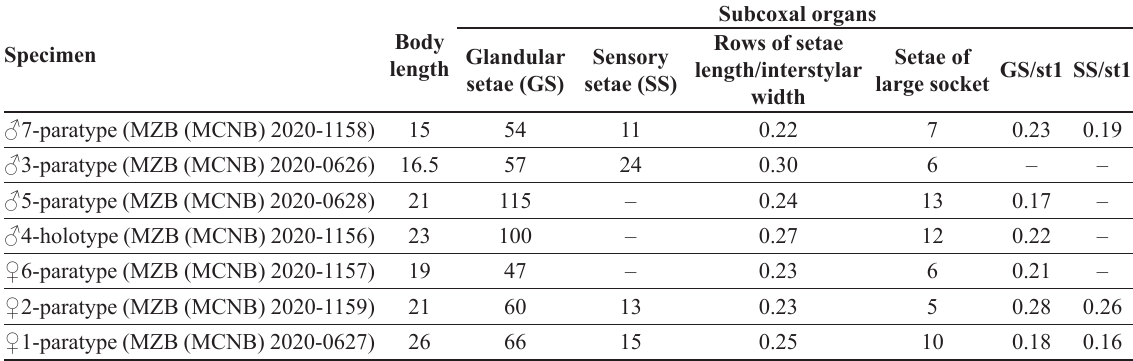
Table 6. Mueggenjapyx brehieri Sendra & Komerički gen. et sp. nov., subcoxal organs with number of glandular, sensory setae and large socket setae including body, interstylar width-length in mm and index of GS/st1 and